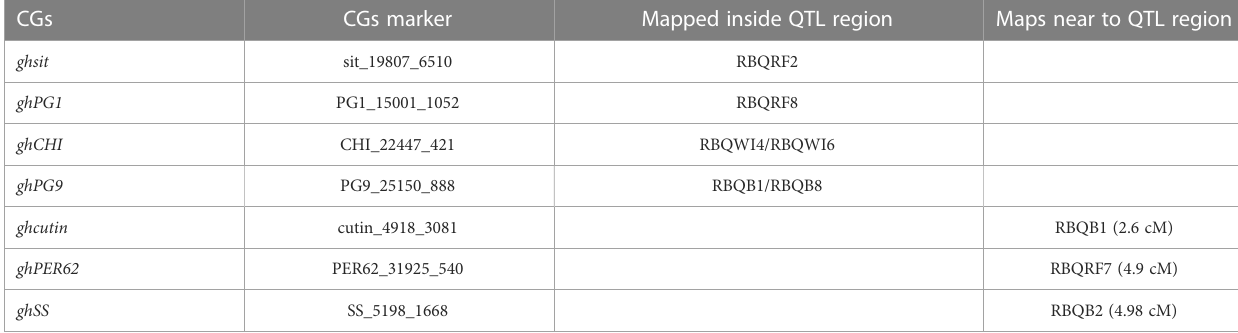
TABLE 1 CGs co-localized with QTLs